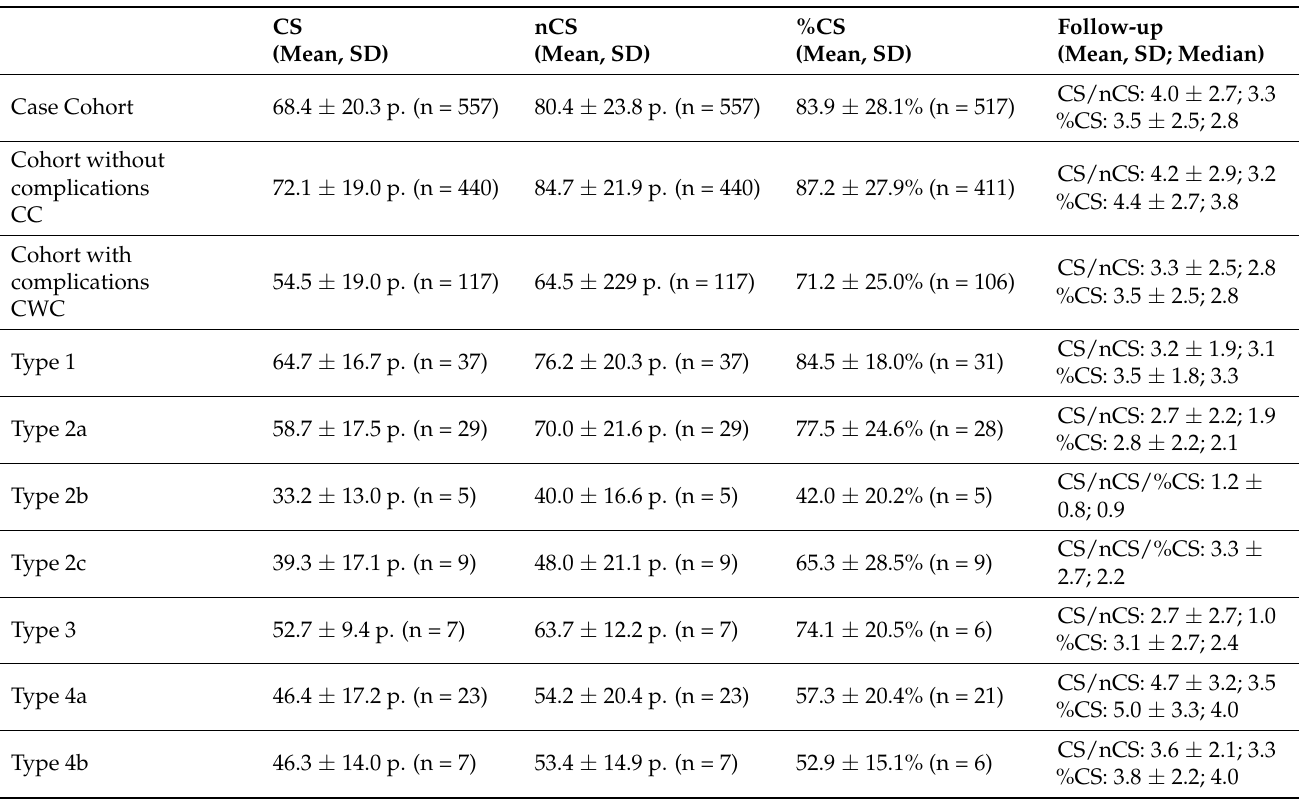
Table 3. Functional outcomes by means of mean and standard deviation of CS, nCS, and %CS of the case cohort; cohort without complications; complication types; and the complication collective in total as well as the respective follow-up of the functional scores in years (mean, standard deviation and